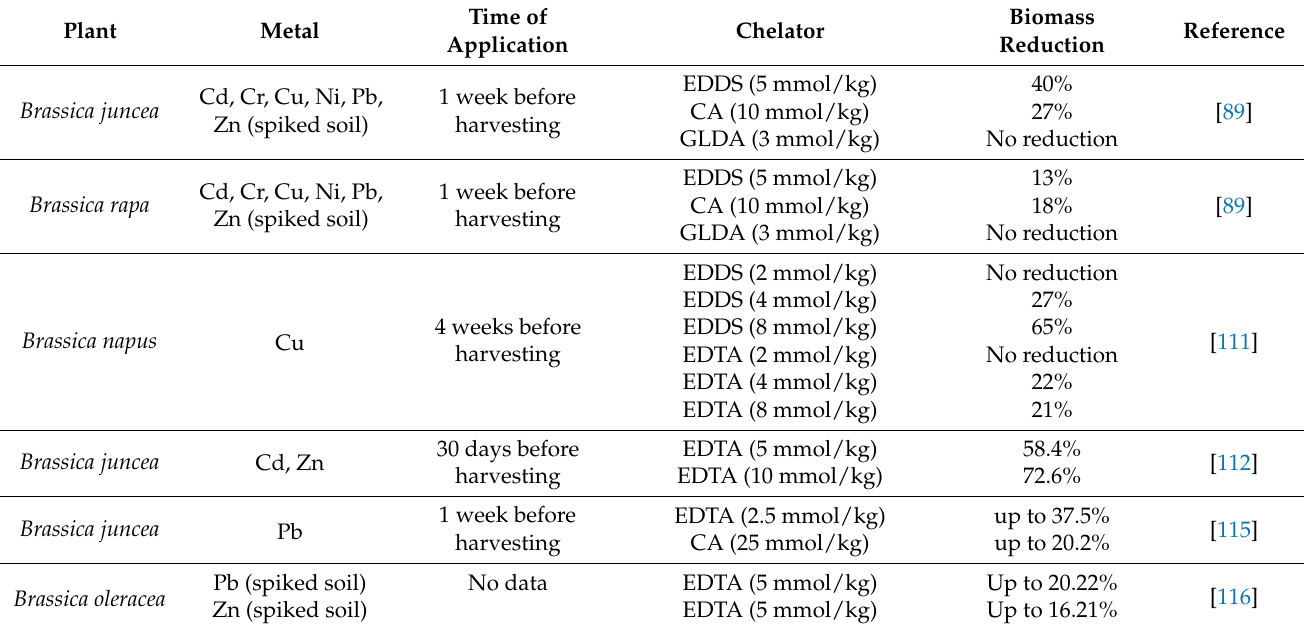
Table 2. The influence of chelator application on biomass reduction in Brassica